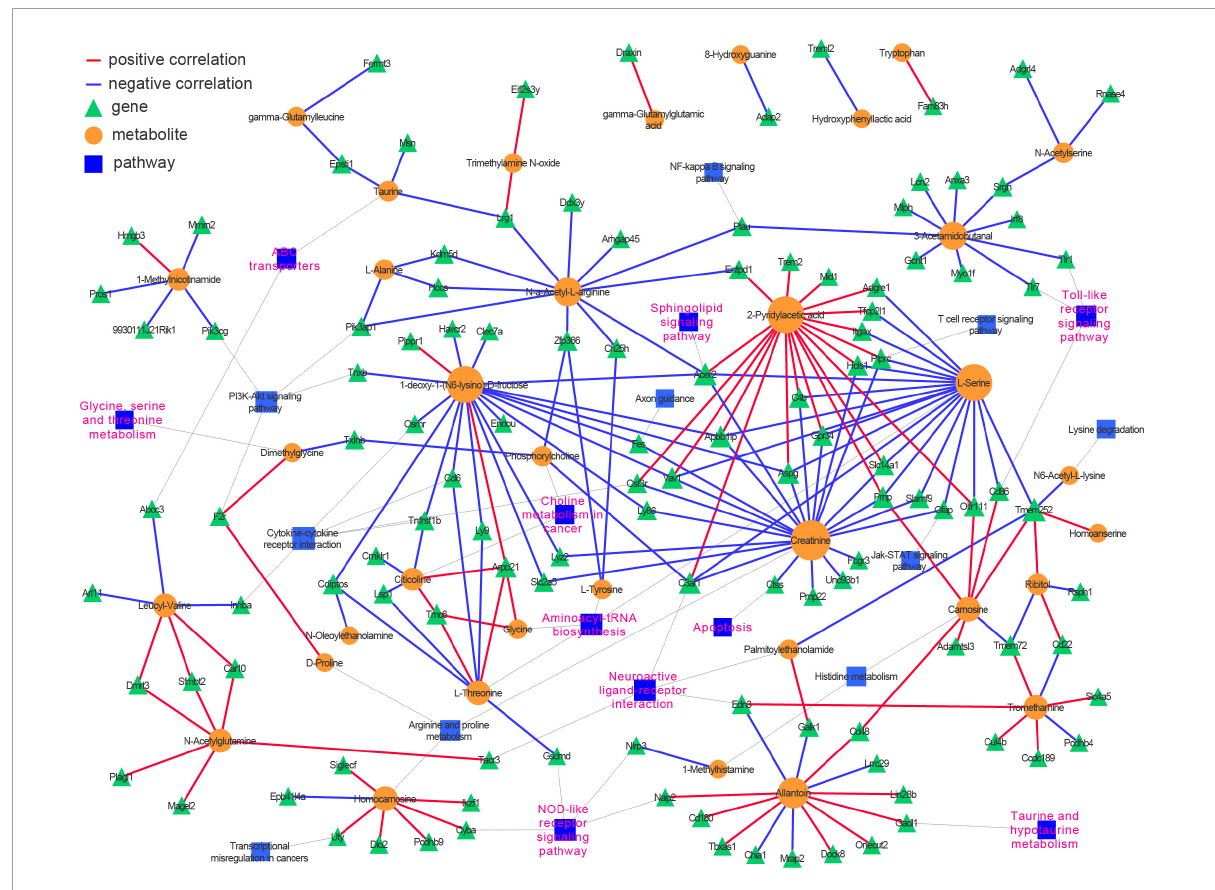
FIGURE6 Integrative analysis of transcriptomics and metabolomics identifies neuroinflammation, amino acids metabolism, sphingolipid signaling pathways, and neuroactive ligand and receptor interaction over presented in the hippocampus of aged mice. Pearson correlation between genes and metabolites was calculated, and the top-ranked correlations (| r| ≥ 0.9825 and p < 0.00046) were employed to construct the genes-metabolites co-expression network. The genes and metabolites were incorporated into their corresponding KEGG pathways.